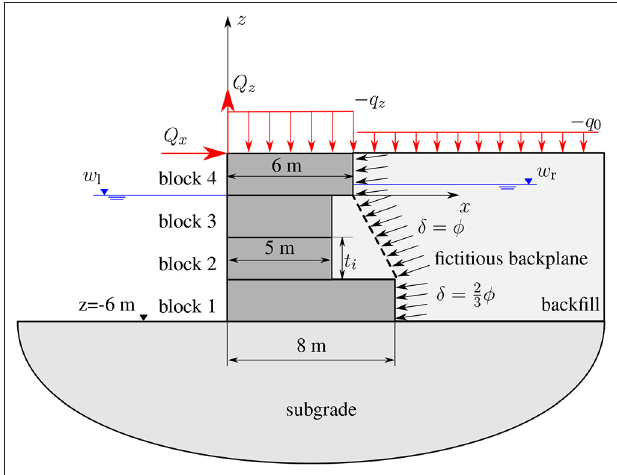
FIGURE 1 | Geometry of a block wall consisting of four rectangular blocks.